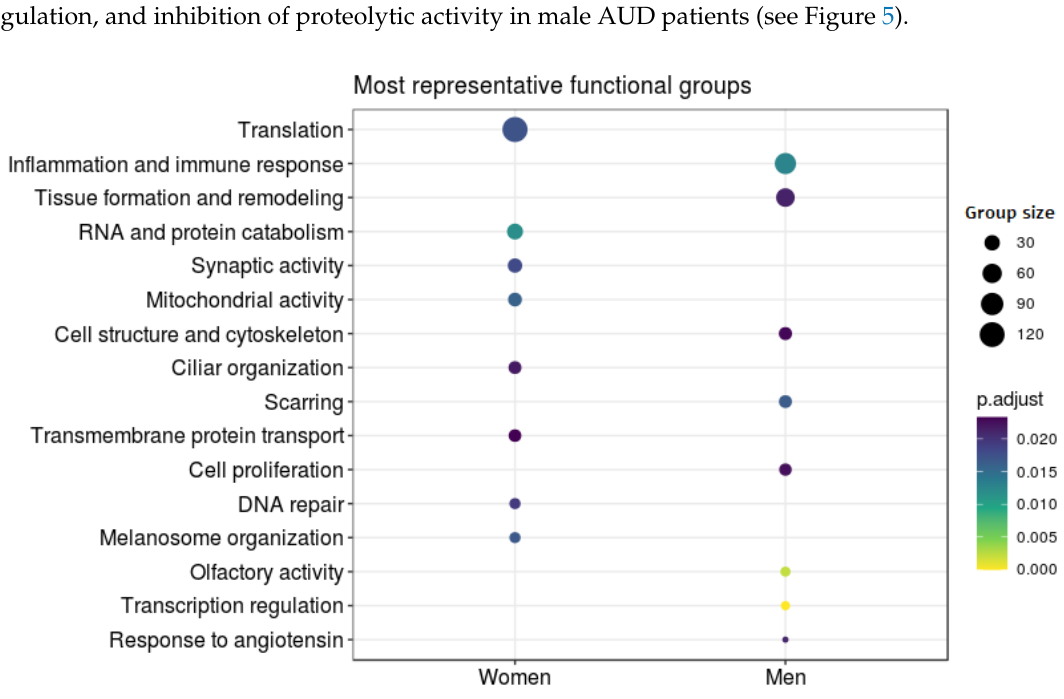
Figure 5. Differential Functional Profiling by Sex. The dot plot shows the functional groups with the greatest differential activity between the sexes. Each dot represents a biological function. Size indicates the number of genes involved in that function and color associated with the level of